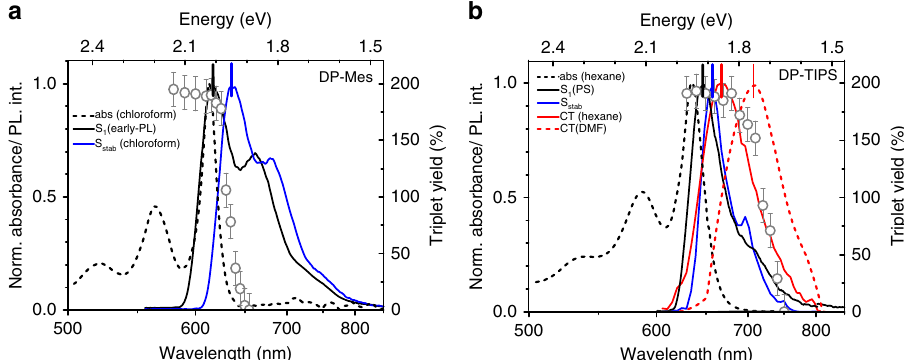
Figure 7 | Excitation-dependent triplet yield. ( a ) Absorption (dashed) and prompt (black) PL spectra of DP-Mes in hexane and the corresponding extracted triplet yield (circles) as function of excitation energy. Full TA datasets presented in Supplementary Fig. 15. Delayed PL spectrum in chloroform (blue) presented for reference. ( b ) Absorption of DP-TIPS in hexane (dashed black), steady-state PL spectra in polystyrene matrix (unrelaxed S 1 , black) and DMF (CT, dashed red) and extracted PL components in hexane (prompt ¼ relaxed S 1 , blue; delayed ¼ CT, red). The corresponding triplet yield in a series of solvents (circles) follows the CT band rather than (S 1 ) absorption edge, revealing SF from direct CTexcitation to a threshold of 750nm. Triplet yields are approximated by comparing the CT to TTexcited-state absorption strength, benchmarked against the ratio in o -DCB following resonant excitation, where nearly quantitative SF is seen. Full TA datasets presented in Supplementary Fig. 23. Vertical bars at the peaks of PL spectra indicate the assigned energy of the emissive state. Errors bars reflect the error in calculating triplet